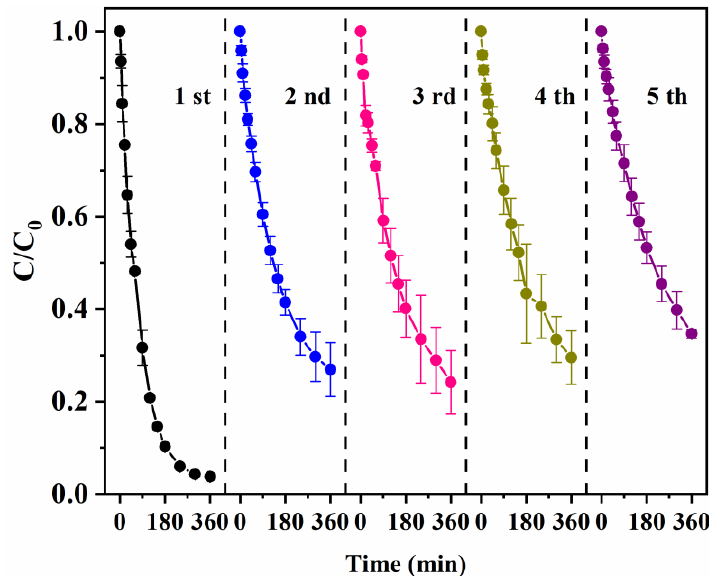
Figure 5. The recycling of nZVI/PA composites.